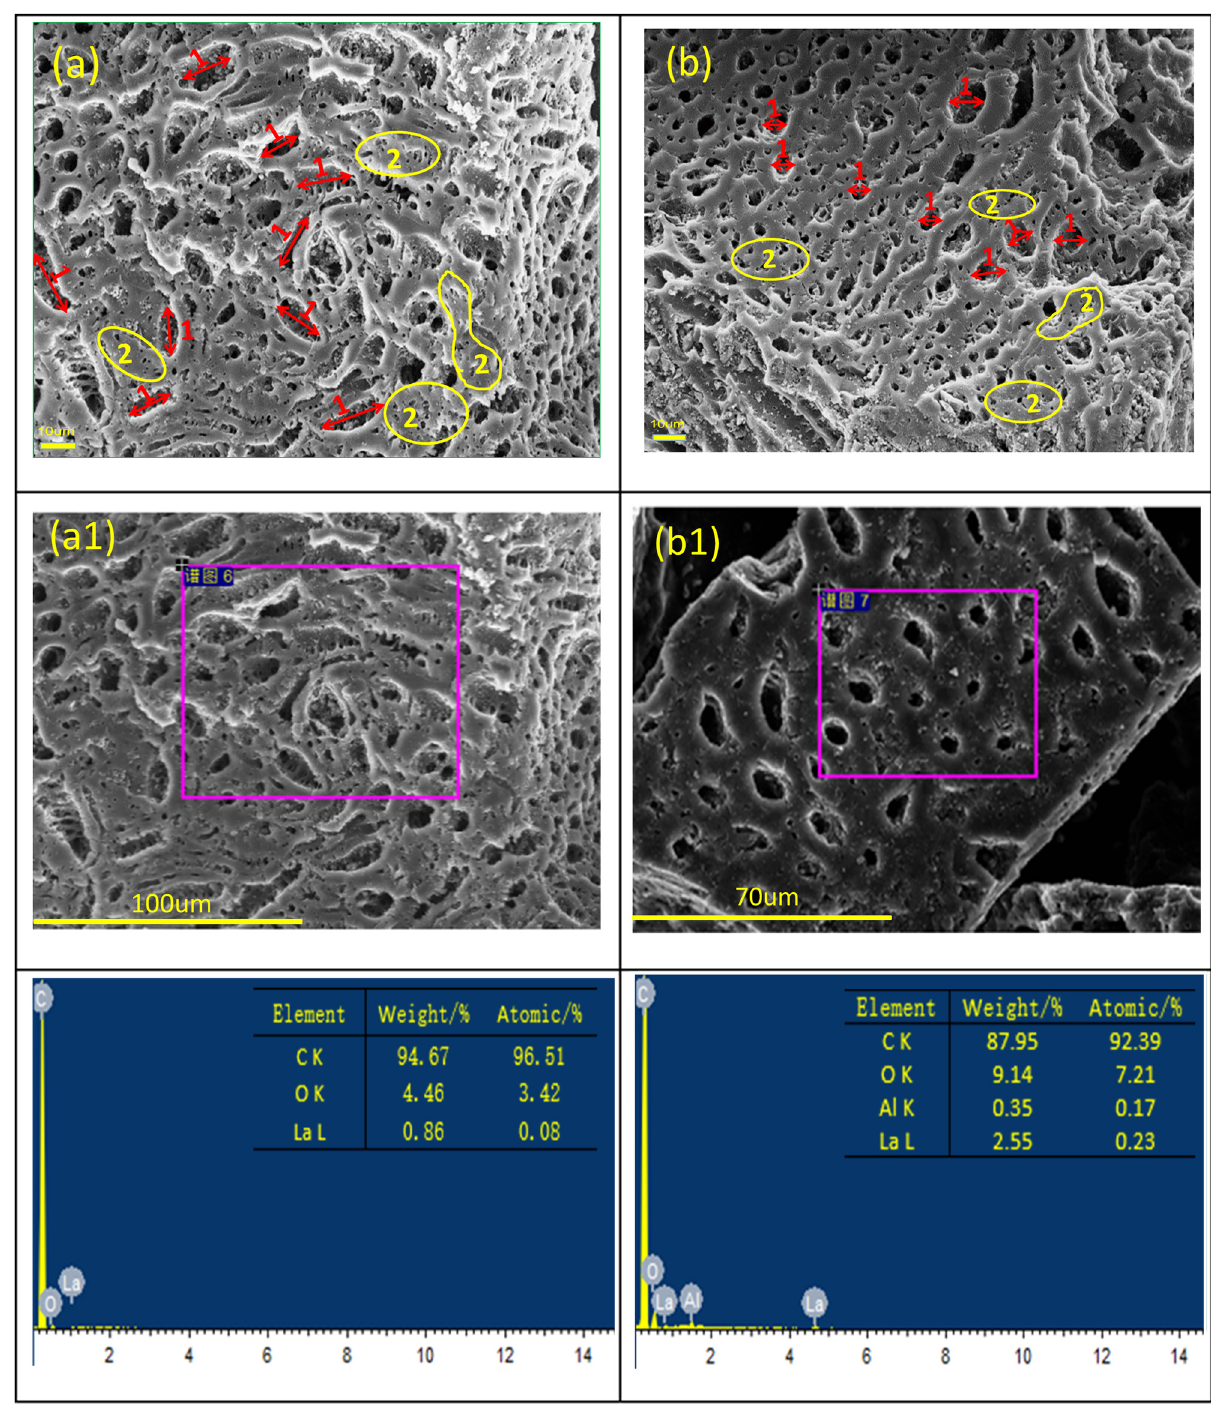
Figure 3: The SEM and EDS analyses of La ( III ) – Al ( III ) – CAC: ( a, a1, a2 ) La ( III ) – CAC and ( b, b1, b2 ) La ( III ) – Al ( III ) –